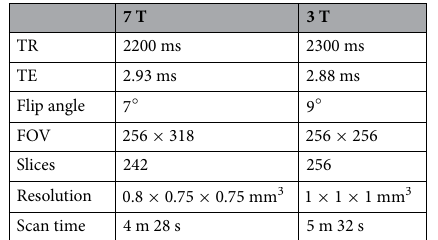
Table 1. Parameters for the MPRAGE T1w sequences run on 7T and 3T